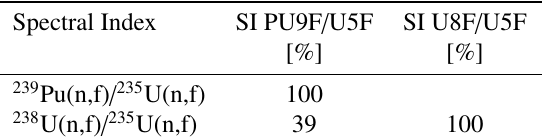
Table 10: Experimental correlations for Adamov et al.[27].